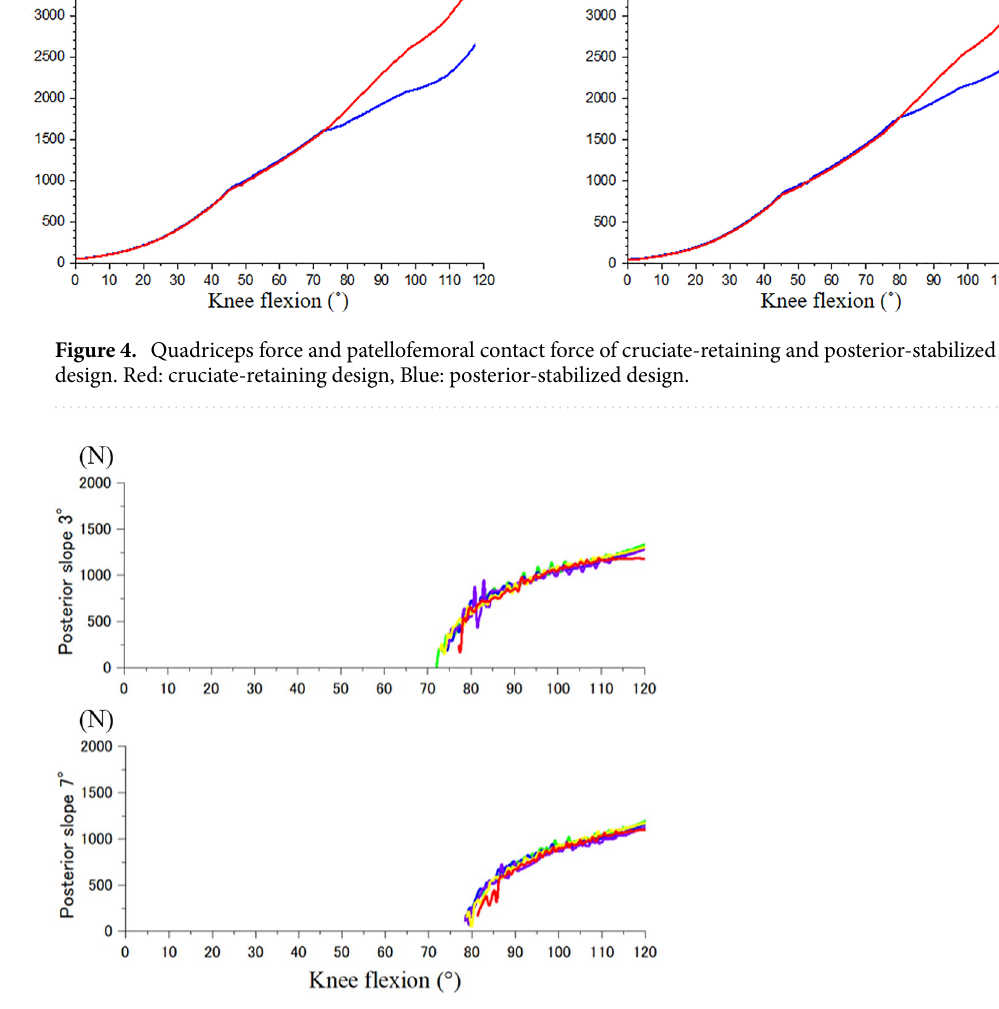
Figure 5. Posterior-cam contact force of posterior-stabilized design. Red: internal 10°, yellow: internal 5°, green: neutral, blue: external 5°, purple: external